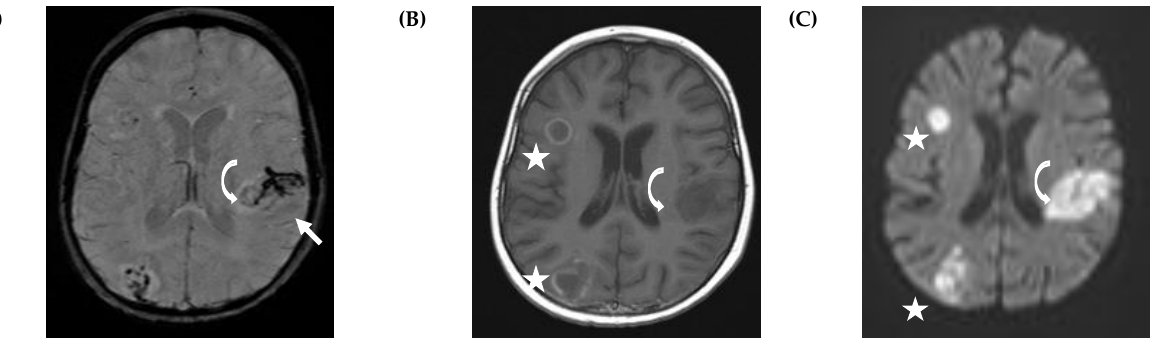
Figure 4. Vascular involvement in a 3-year-old girl with acute lymphoblastic leukemia (ALL) and proven central nervous system invasive mold infection (CNS IMD). The patient is alive but is a wheelchair user. Immunocompromised children have an impaired host immune system to fight against fungi (Figure 4A, curved arrow), which often results in an infiltration of the vascular structures (Figure 4A, straight arrow). Susceptibility-weighted image (SWI) ( A ) shows ring-like fungal infection on the left side (curved arrow) and thrombosis of the deep medullary veins (straight arrow), which are visualized as low signal intensity at SWI. Enhanced T1W ( B ) shows multiple ring-enhancing fungal abscesses on the right (star), but no enhancement on the left side. Diffusion-weighted image (DWI) ( C ) shows restricted diffusion within multiple ring-enhancing fungal abscesses on the right (star). The infarct with diffusion restriction (C) on the left involves the nonenhancing ring-like structure shown in the SWI (A, curved